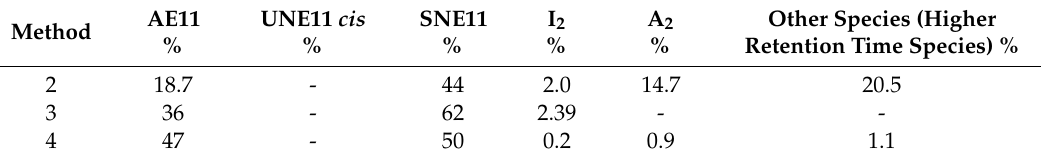
Table 8. 2 : Solution of catalyst reactivation under MeOH and silent conditions, 3 : solution of catalyst reactivation under MeOH, sonication treatment at 120 kHz and 100W, 4 : solution of catalyst reactivation under MeOH, sonication treatment at 120 kHz and 200W. AE11 : methyl-11-aminoundecanoate, UNE11 : (9 Z )-10-cyano-9-decenoate, SNE11 : methyl-10-cyanodecanoate. I 2 : secondary imine, A 2 : secondary amine, Dimer : dimer of AE11 (see Scheme 2 for molecular structure). Percentages of the reaction species were measured by GC–FID relative peak area.